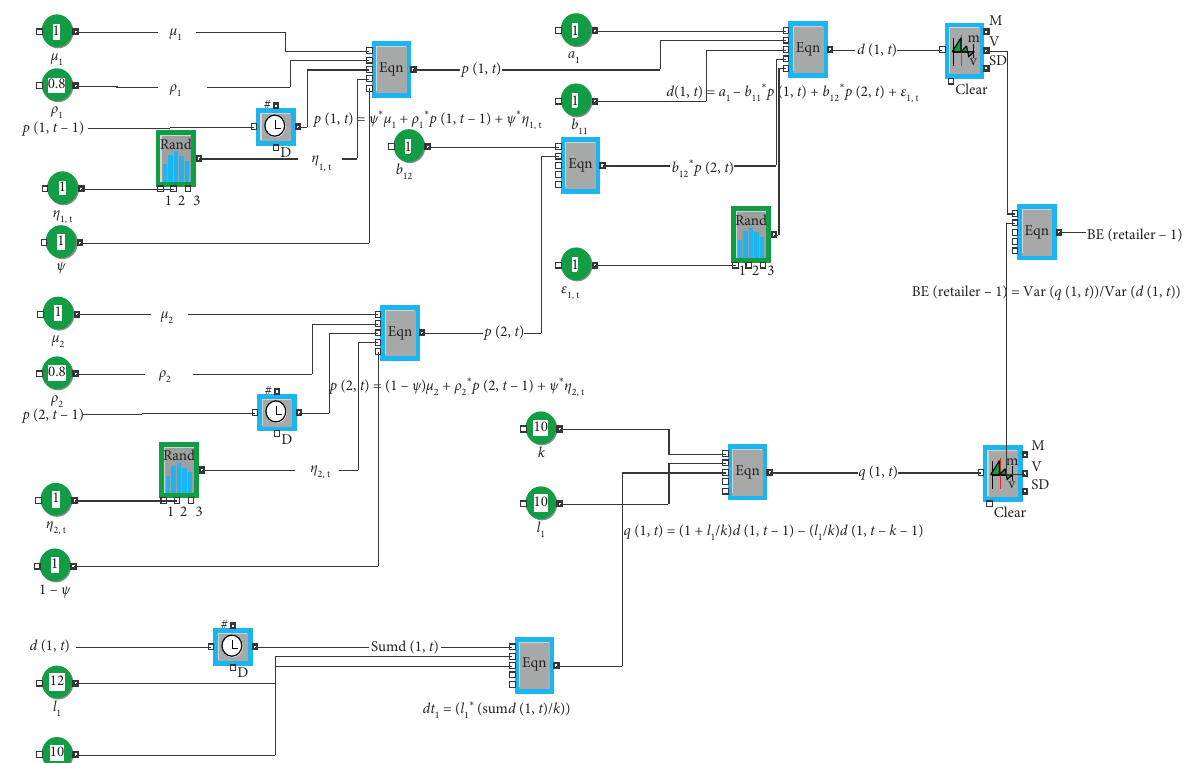
Figure 2: The simulation model of the bullwhip effect based on the MA